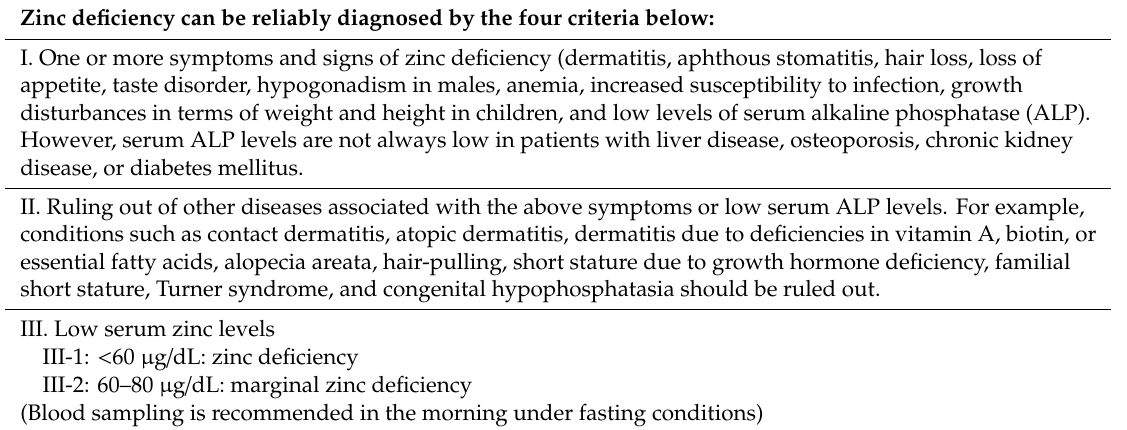
Table 1. The diagnostic guideline for zinc